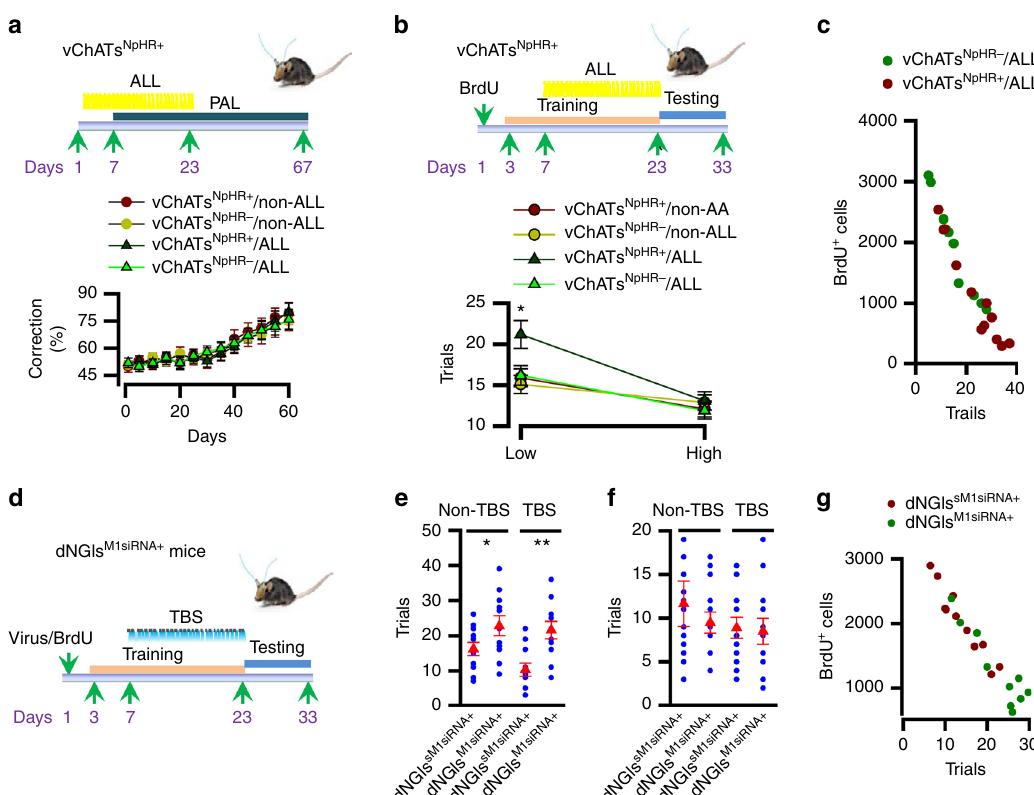
Fig. 5 Inhibition of spatial pattern separation reduces the dNGIs survival. a The experimental schedules (top) show that mice at 120 ± 2 days old of age were applied with ALL. 7 days after the beginning of ALL, mice were performed with 16-days PAL. The percentage (bottom) of corrections in 60-days PAL is plotted (mean ± SEM, n = 11 mice/group). b The experimental schedules (top) show that mice (after the completion of PAL) were administered with a single dose of BrdU. 7 days after the administration, mice were trained with 2-CSD. 4 days after the beginning of the training, mice were treated with 16- days ALL. The mice were applied for a 5-day block test on each separation (high or low). Immediately after end of the tests, mice were euthanized for BrdU staining. The numbers (bottom) of trials that are required to reach a criterion at a high or a low separation of 2-CSD (mean ± SEM, n = 11 mice/group, F 1.43 = 9.87; * p = 0.00098, two-way ANOVA). c , The numbers of trials that are required to reach a criterion at a low separation in b are plotted against the number of BrdU + cells from the individual mice (Rsqr = 0.92 in vChATs NpHR − /ALL vs. 0.94 in vChATs NpHR+ /ALL mice). d – f The experimental schedules d , and the actual (blue circles) and averaged trials that are required to reach a criterion at a low e , or a high f , separation of 2-CSD from the individual mice (mean ± SEM, n = 11 mice/group, F 1.43 = 9.79, * p = 0.0012, ** p = 0.00082, two-way ANOVA). g The numbers of trials that are required to reach a criterion at a low separation in e are plotted against the number of BrdU + cells from the individual animals that were treated with TBS (Rsqr = 0.936 in dNGIs sM1siRNA+ vs. 0.648 in dNGIs M1siRNA+